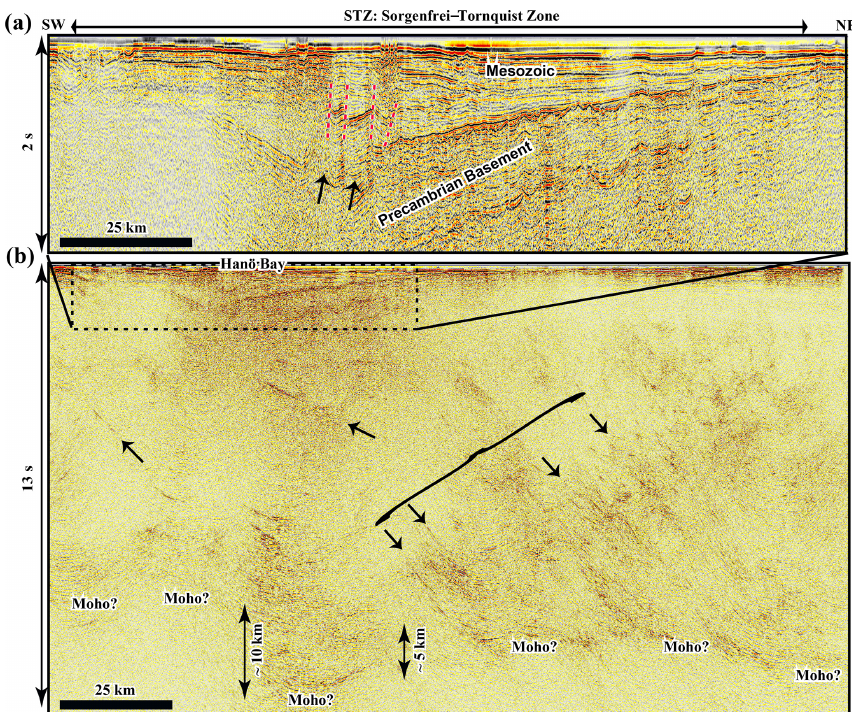
Figure 16. Reprocessed (only poststack processing) and migrated seismic section of BABEL offshore lines A-AA-AB (BABEL Working Group, 1993) across the Sorgenfrei–Tornquist Zone (a) Hanö Bay basin area. The whole seismic section is shown in panel (b) , including a clear Moho step under the Hanö Bay basin. Clear faults are evident in the Hanö Bay basin and show a throw offset as much as 200–500m and a multiphase history (both reverse and normal faulting). NE-dipping reflections are dominant in the lower crust projecting to the Tornquist zone. The original work did not present such a clear Moho keel and migration was done on line drawings likely using a 1-D or constant velocity model (BABEL Working Group,